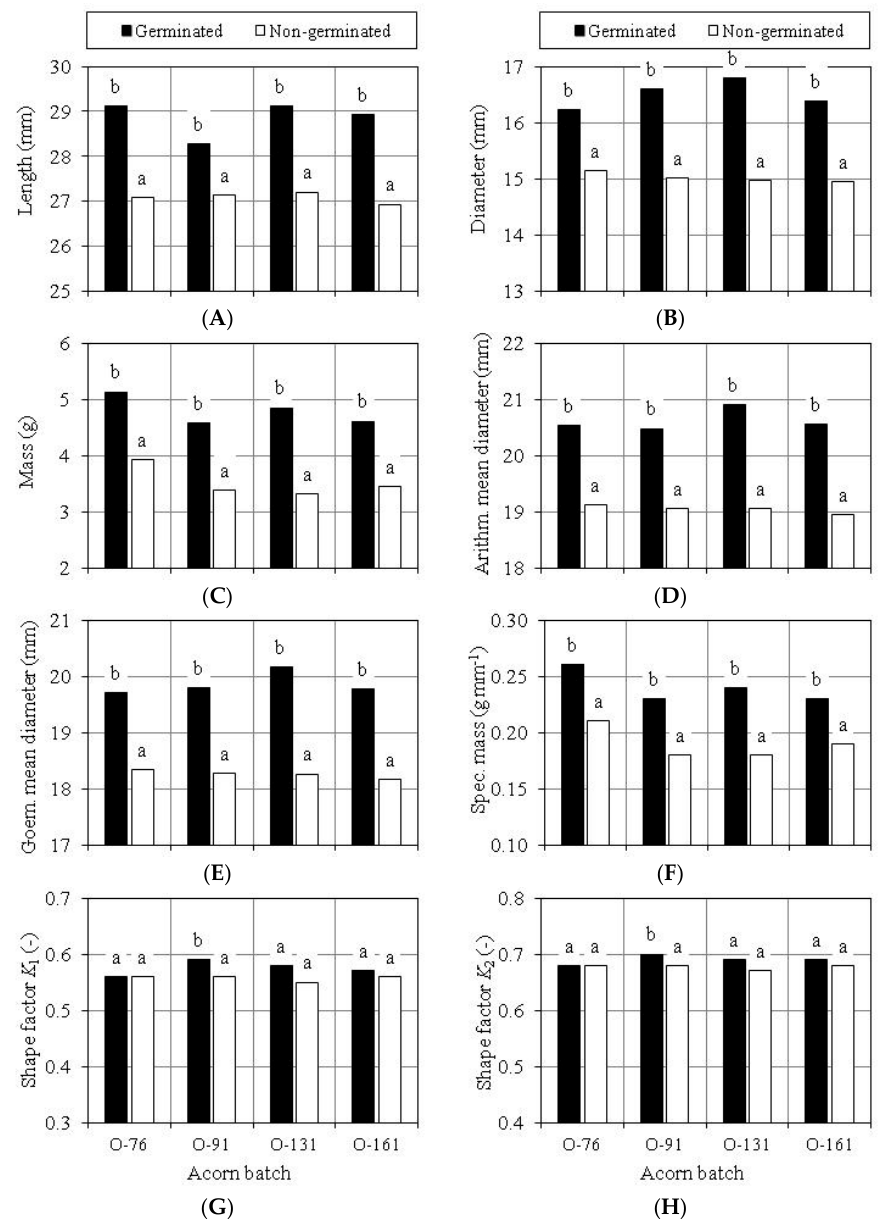
Figure 4. Significance of differences in the length ( A ), diameter ( B ), mass ( C ), arithmetic mean diameter ( D ), geometric mean diameter ( E ), specific mass ( F ), shape factor K 1 ( G ) and shape factor K 2 ( H ) of germinated and non-germinated acorns subjected to scarification; a, b—different letters denote statistically significant differences.